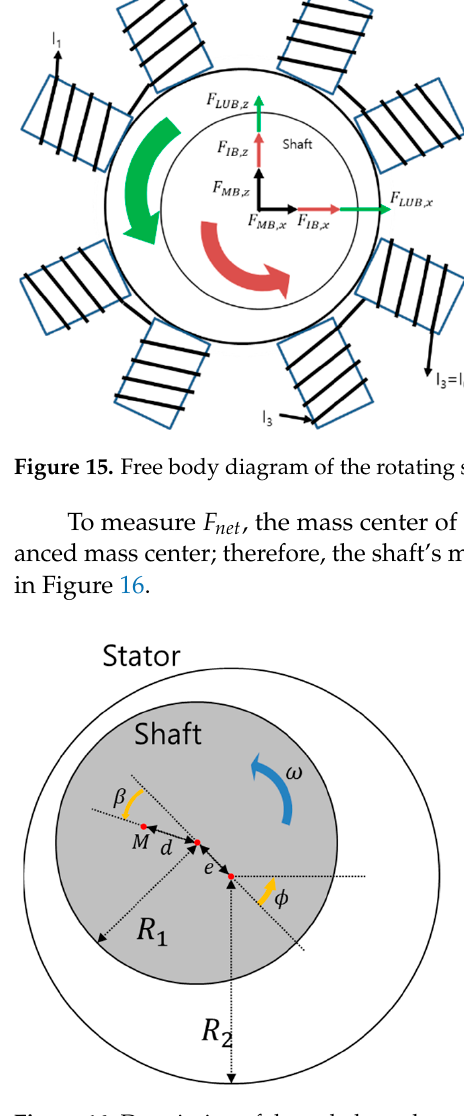
Figure 14. Layout of the magnetic bearing instability experiment.